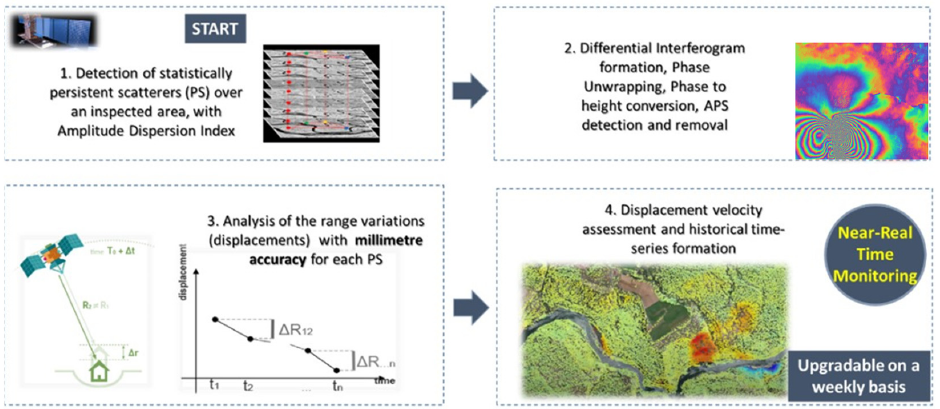
Figure 8. Schematic overview of the processing steps of the PS technique.